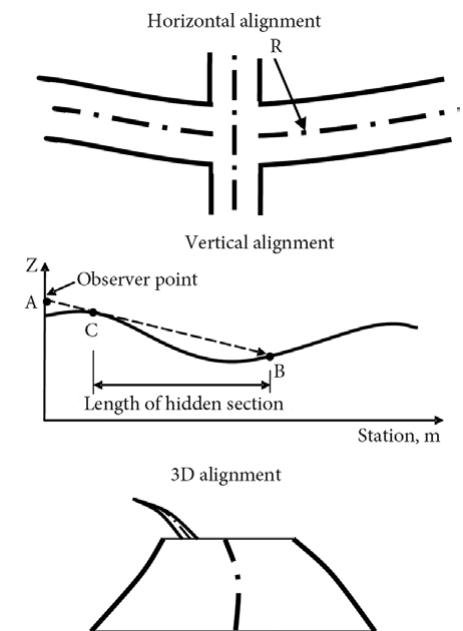
Fig. 2. Hidden dip in a horizontal